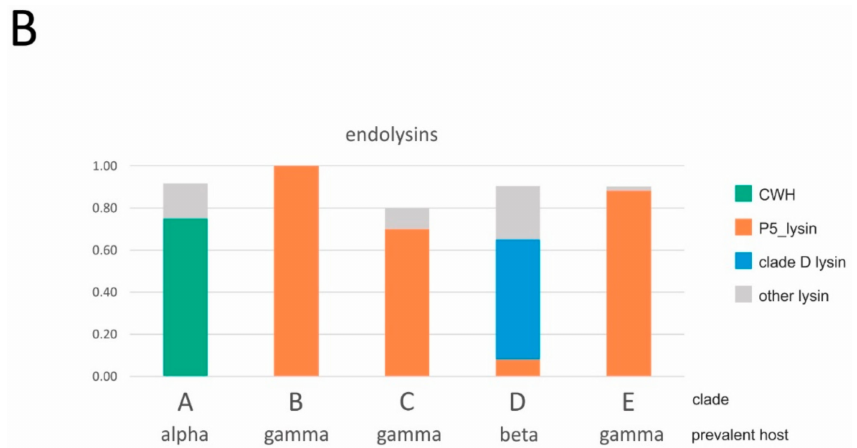
Figure 5. Core genes of Vinavirales . ( A ) The 12 genes defined as Vinavirales core by their presence in all 5 clades (A to E). The bar lengths correspond to the fraction of the genomes in a clade carrying the respective gene. ( B ) Endolysin repertoire of Vinavirales largely follows the predicted host taxonomy. Various subsets of replication proteins, such as DNA polymerase B, non-homologous rolling circle replication initiation endonucleases of the Rep_trans (PF02486) and HUH superfamilies, DnaD- like winged HTH domain replication initiators, and others (Supplementary Files S3 and S5), were identified in nearly all members of Vinavirales . These genes are apparently subject to frequent non- orthologous displacement during the evolution of this phage group, similarly to the replication proteins of crAss-like tailed phages [20]. An example of replication protein replacement is shown in Figure 6. The Paremcibacter congregatus strain ZYLT genome encodes two prophages that belong to clade A. Strikingly, these prophages are nearly identical for most of their length, with the notable exception of the replication genes (divergent Rep_1 family rolling circle replication endonucleases of the HUH superfamily; pfam01446) and two or three ORFs upstream of these genes. The replication proteins and the upstream ORFs lack detectble sequence similarity between the two prophages, and the upstream ORFs in each phage encode short (80–110 aa) proteins with no detectable homologs in current sequence databases.